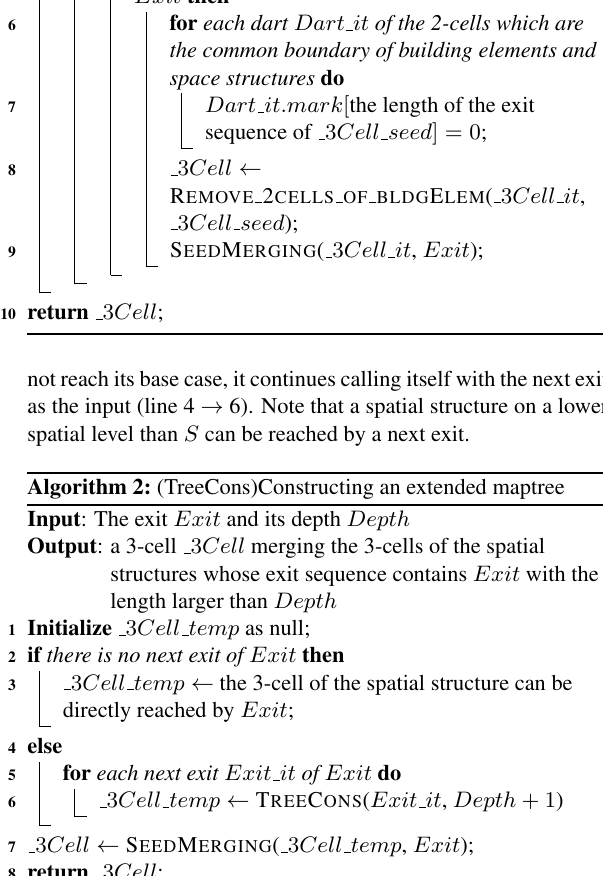
Figure 10. Sew 3-cells by connection surface